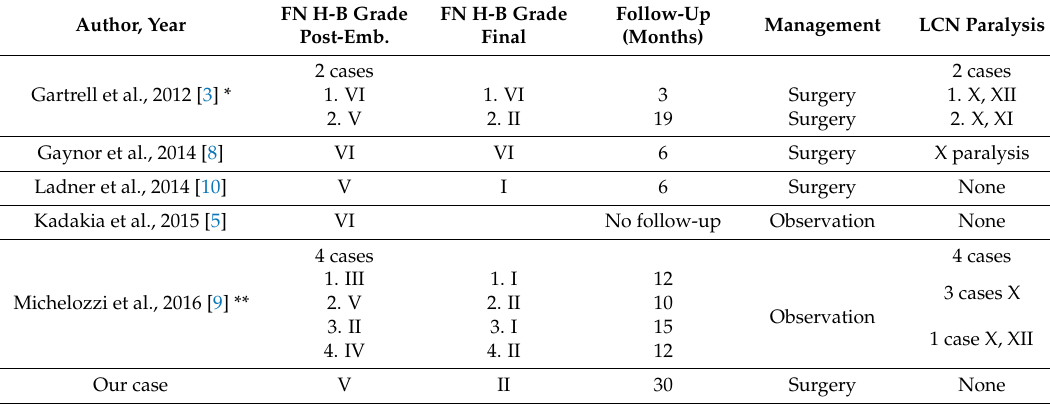
Table 1. Reported jugular paraganglioma cases with post-Onyx facial nerve